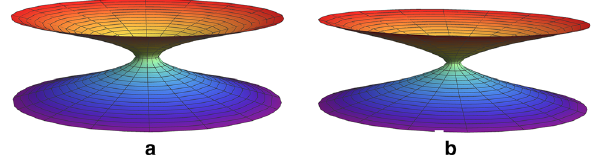
Fig. 14 Embedding diagram for the wormhole at the centre bulge with η = 0 . 003 for a NFW profile: r kpc